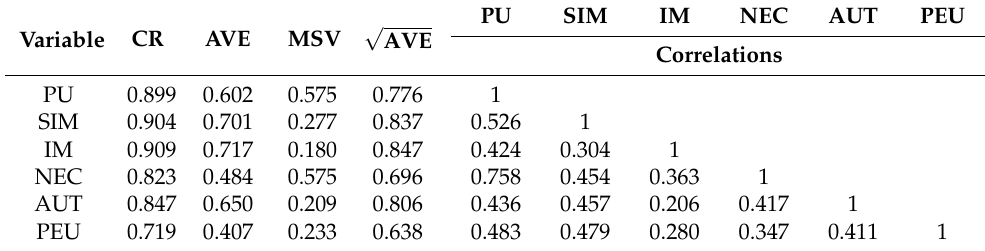
Figure 2. Confirmatory Factor Analysis model. Source: Authors’ own research. Table 6. Convergent validity measures